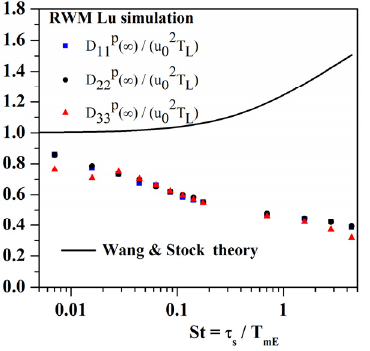
Figure 14. Particle Dispersion coefficient (g = 0).